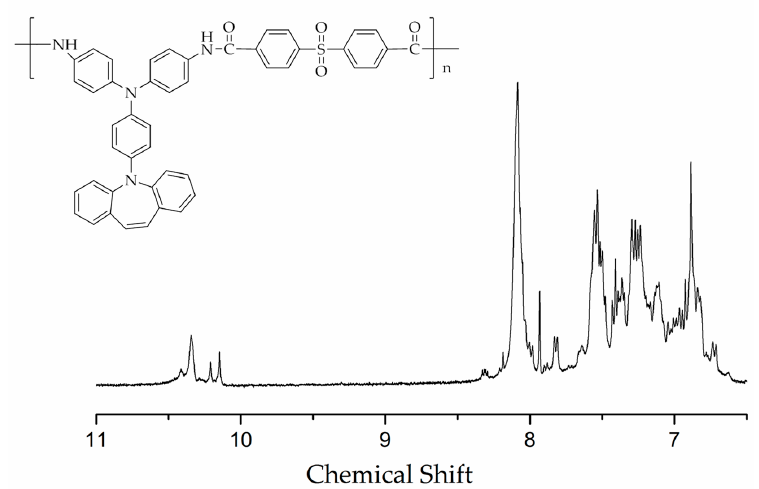
Figure A6. 1 H NMR spectrum of PA–c in DMSO- d 6 .